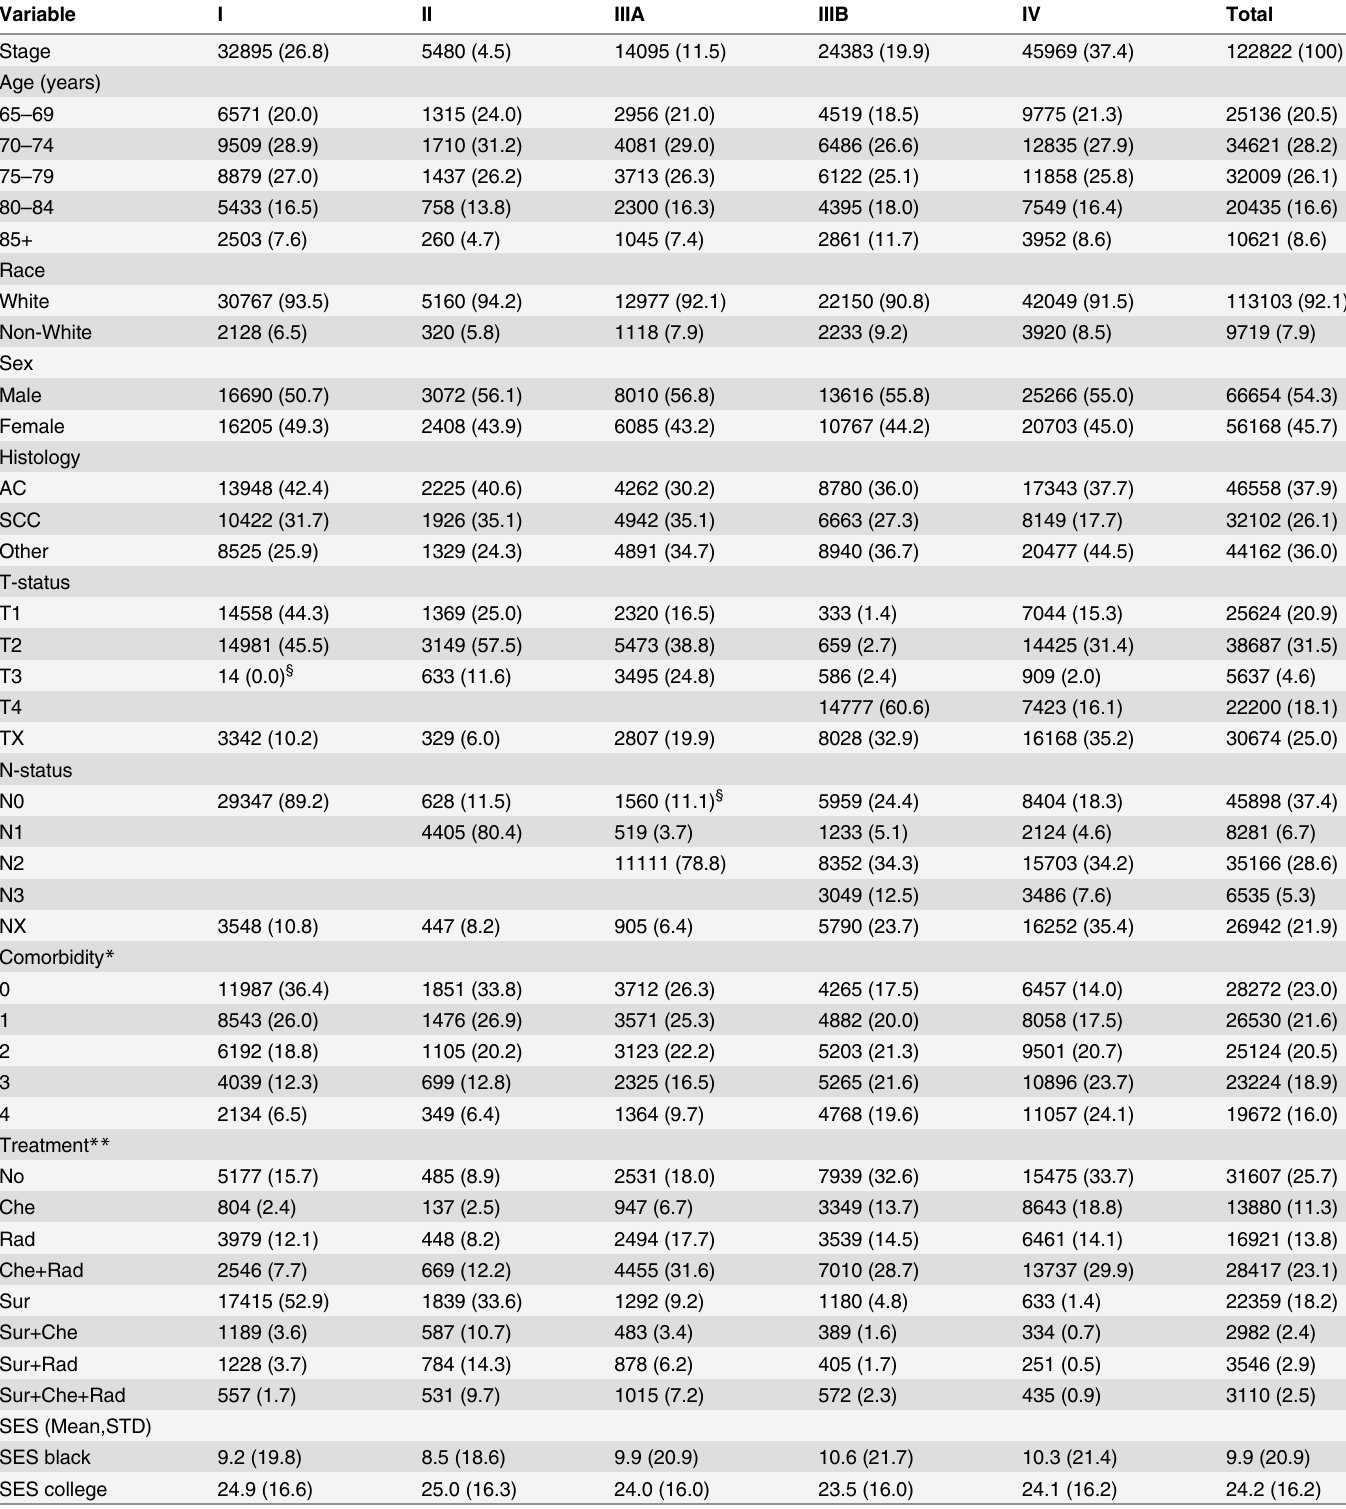
Table 1. Demographic, tumor, socio-economic characteristic and treatment modes for lung cancer patients with stages I, II, IIIA, IIIB, and IV.